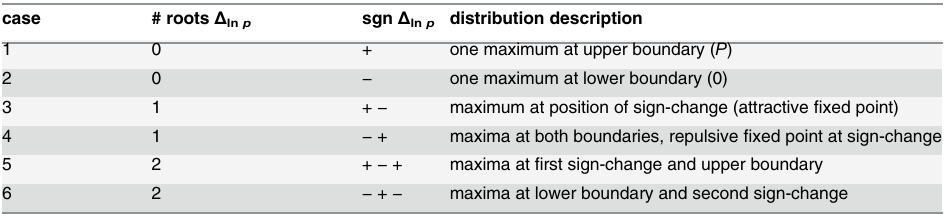
Table 1. Distribution shapes for different numbers of